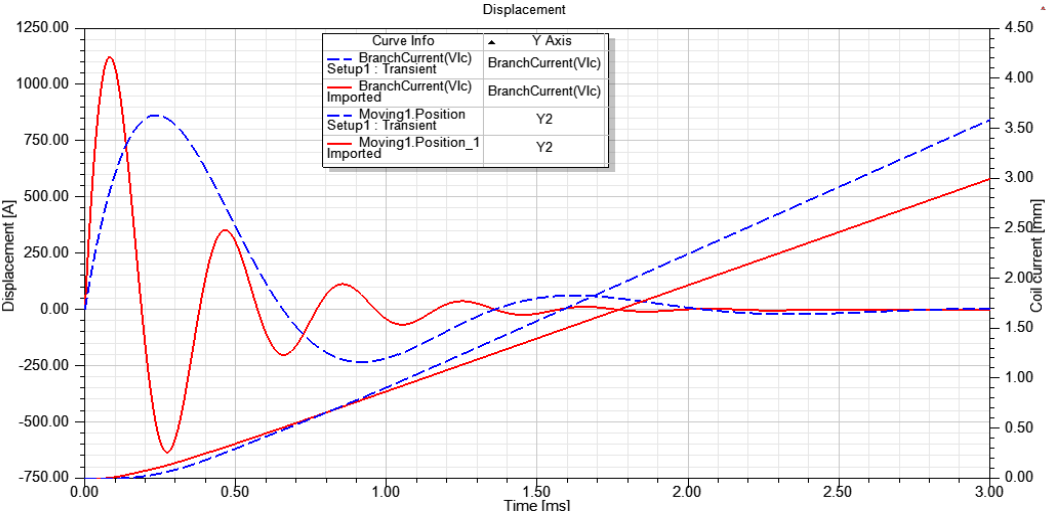
Figure 12. Coil current and disc displacements ( C = 100 μ F red colour, C = 1000 μ F blue colour), (Case 3 from Table 2).